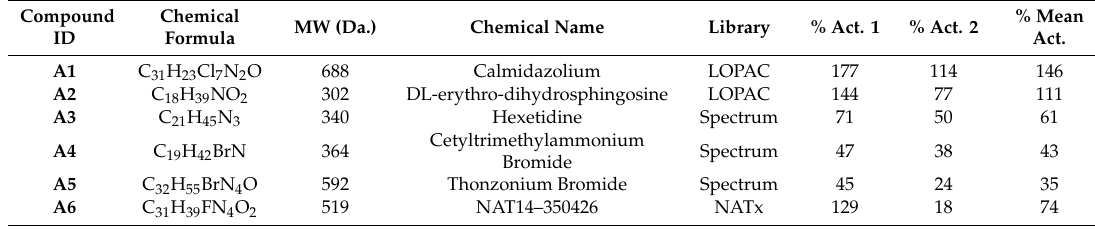
Table 2. WT HYPE activator hit